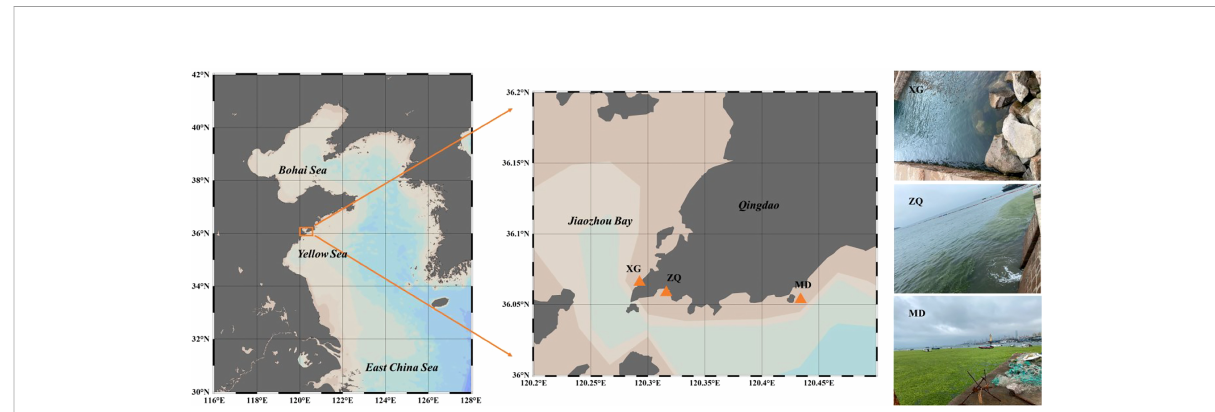
FIGURE 1 Locations of sampling stations chosen in coastal Qingdao areas during an U. prolifera green tide, and the right panel was the photos captured on 11 July, 2019 at three sampling